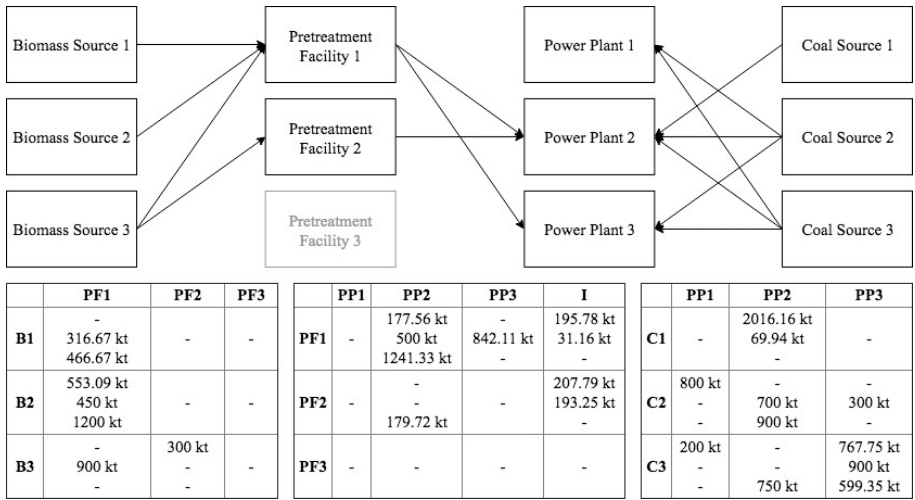
Figure 6. Optimal Biomass Co-firing Network.